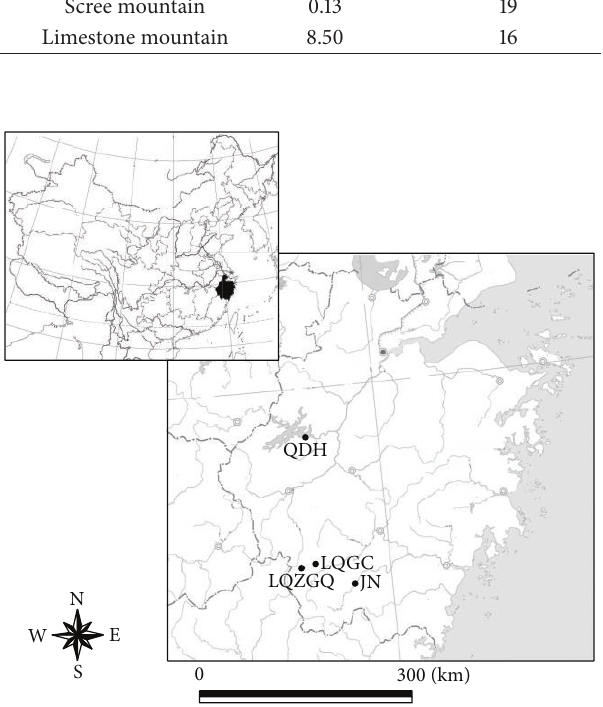
Figure 1: Study sites and distribution of O. fragrans